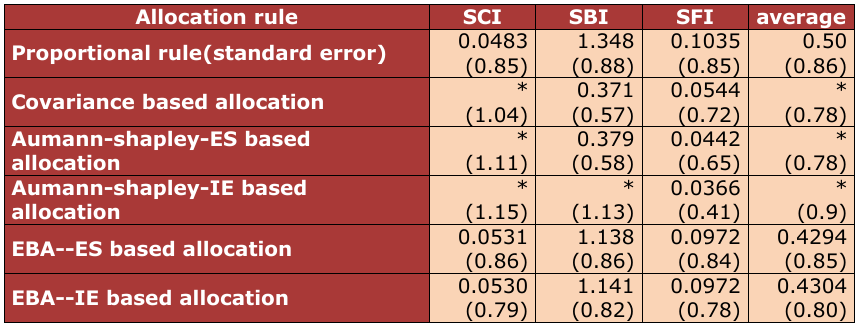
Table 3. RAROC of capital allocation under six